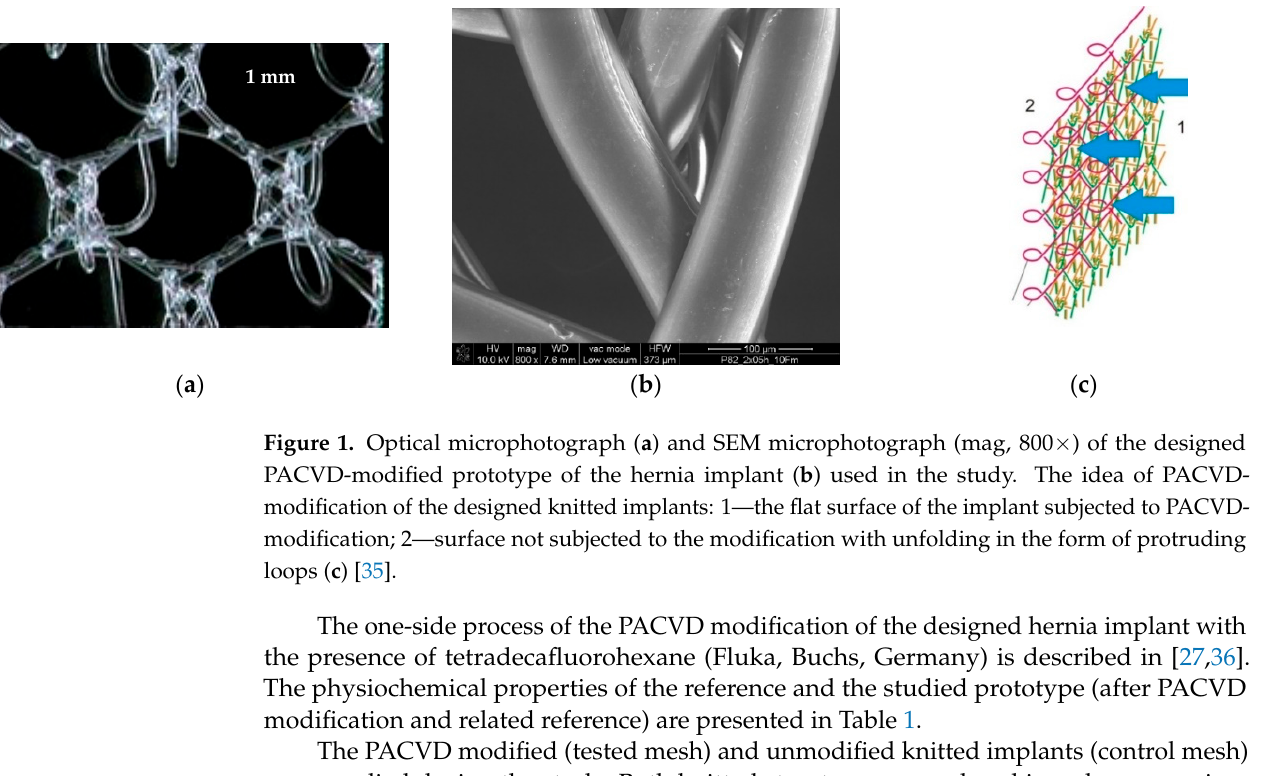
Table 1. Physiochemical properties of the reference and the studied prototype.